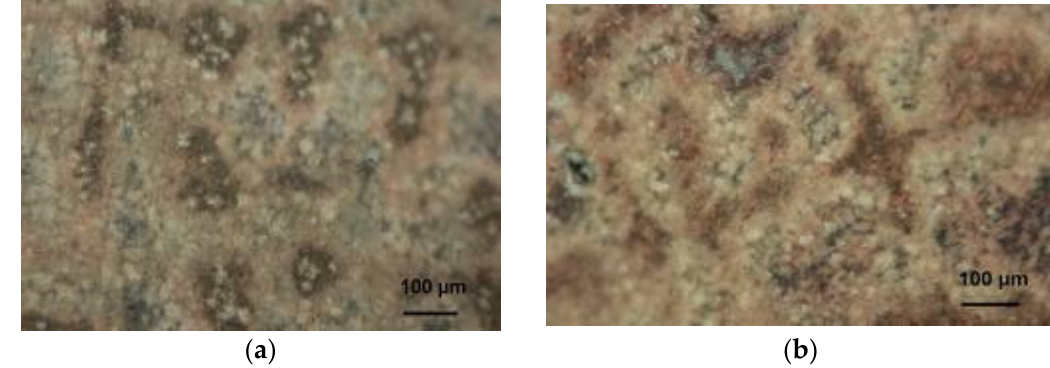
Figure 5. OM pictures (×100) of the corrosion patterns observed at the segregated surface of TB castings after the end of anodic sweeps in 0.6 mol/L NaCl: ( a ) and ( b ) corresponding to two different areas where the cored dendritic structure exhibits local dealloying patterns —These features are encountered near the electrode centre.